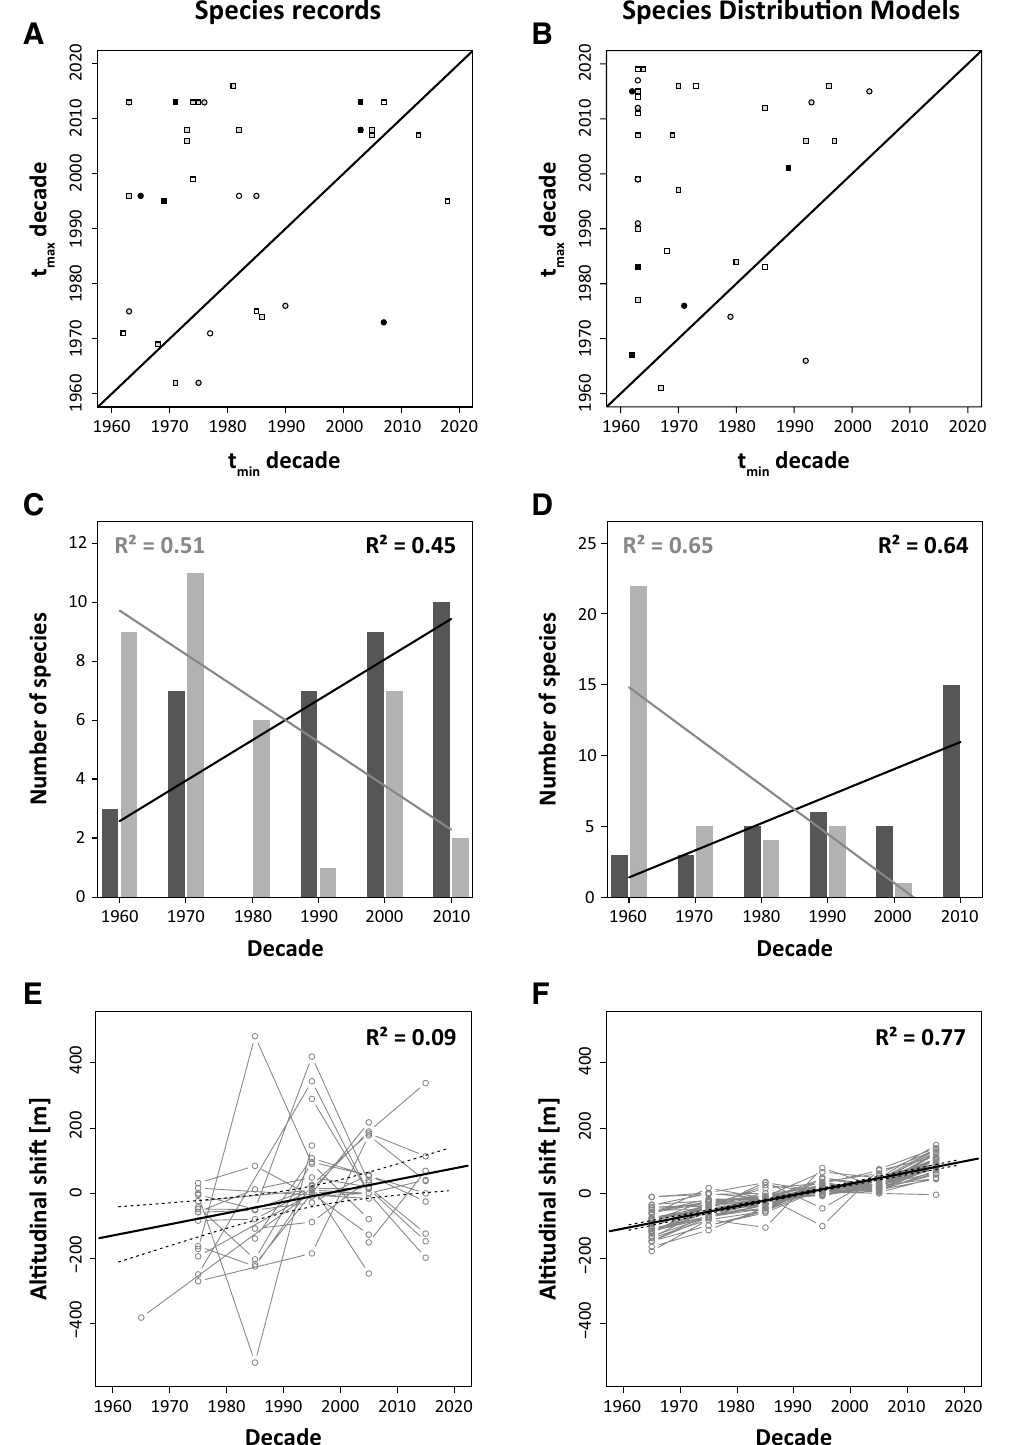
Figure 2. Relationships between the years of minimum and maximum observed ( A ) and modelled ( B ) altitudinal occurrences for 37 mountain butterfly species. The black line denotes the 1:1 relationship. Observed ( C ) and modelled ( D ) numbers of species with their minimum (light grey bars) and maximum (dark grey) observed elevation of occurrence in a focal decade. Median altitudinal shift per decade revealed by the median altitudinal position of each species within a decade minus the median over the complete study period as evident from species records ( E ) and species distribution models ( F ); this analysis was performed for all species. The coefficient of determination R 2 refer to linear ordinary least squares regression. Parametric significances: ** P < 0.01, *** P <